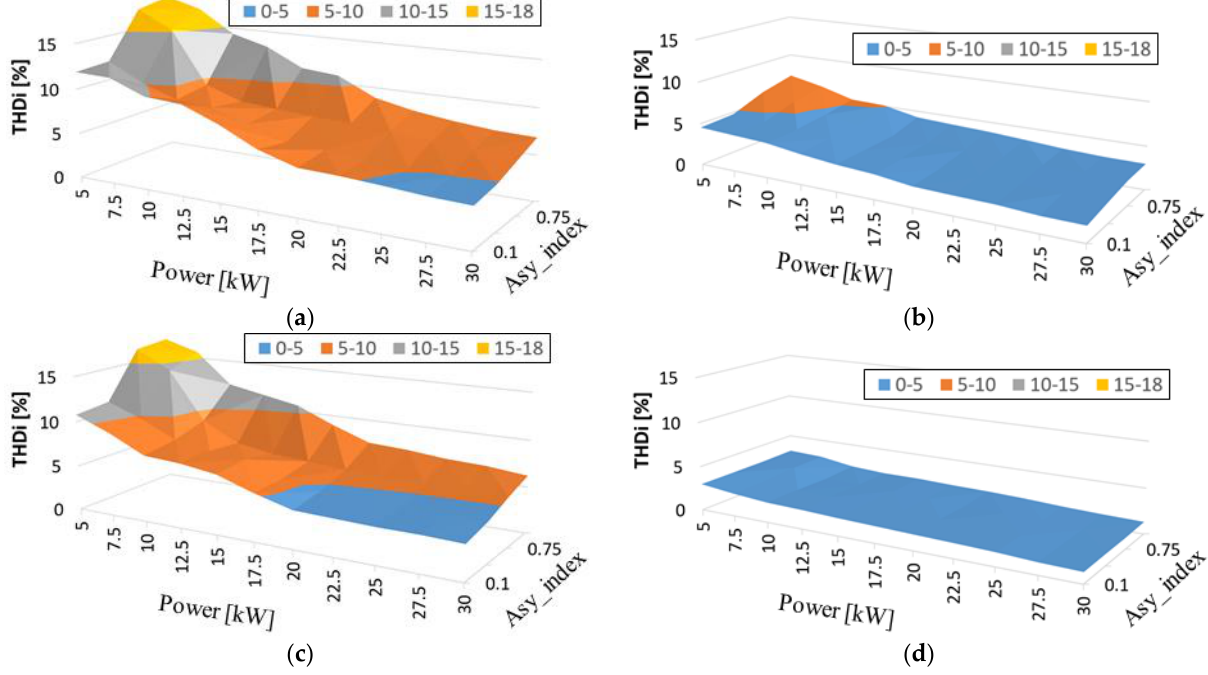
Figure 10. Comparison of current THD performance of a four-leg inverter under unbalanced load condition: ( a ) two-level three-leg four-wire type, ( b ) two-level four-leg type, ( c ) three-level three-leg four-wire type, and ( d ) three-level type four-leg inverter.